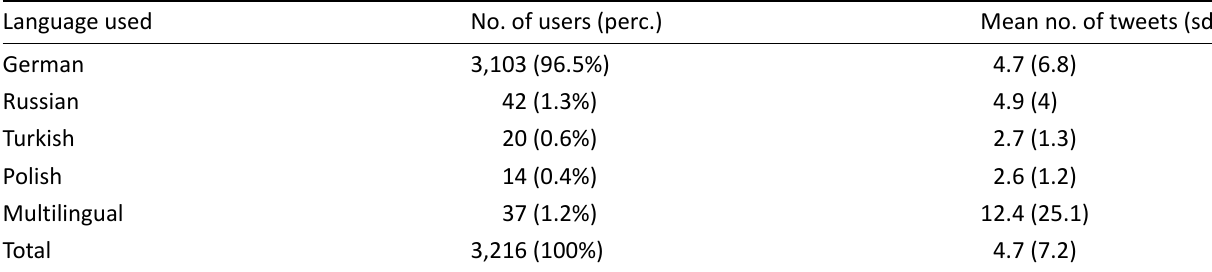
Table 1. Languages used by Twitter users under study. Language